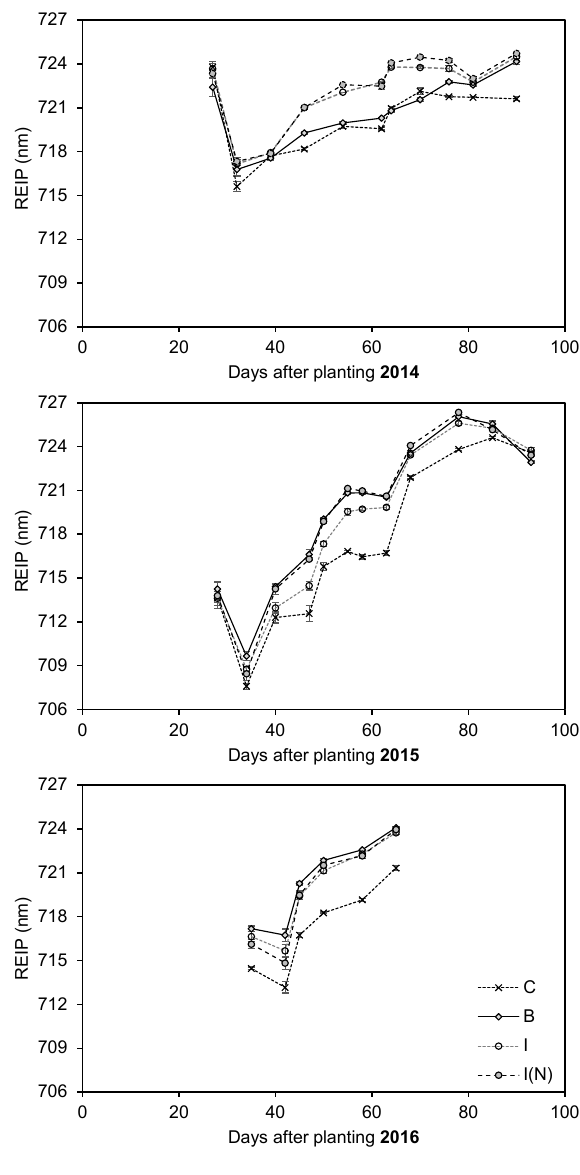
Figure 3: Development of REIP values for treatments in the Hollage experiment in 2014, 2015, and 2016. Means of treatments fertilized with manure and mineral starter fertilizer (MSF) [C = no manure, no MSF, B = manure broadcast with MSF, I = manure injection without MSF, I(N) = manure injection with nitrification inhibitor without